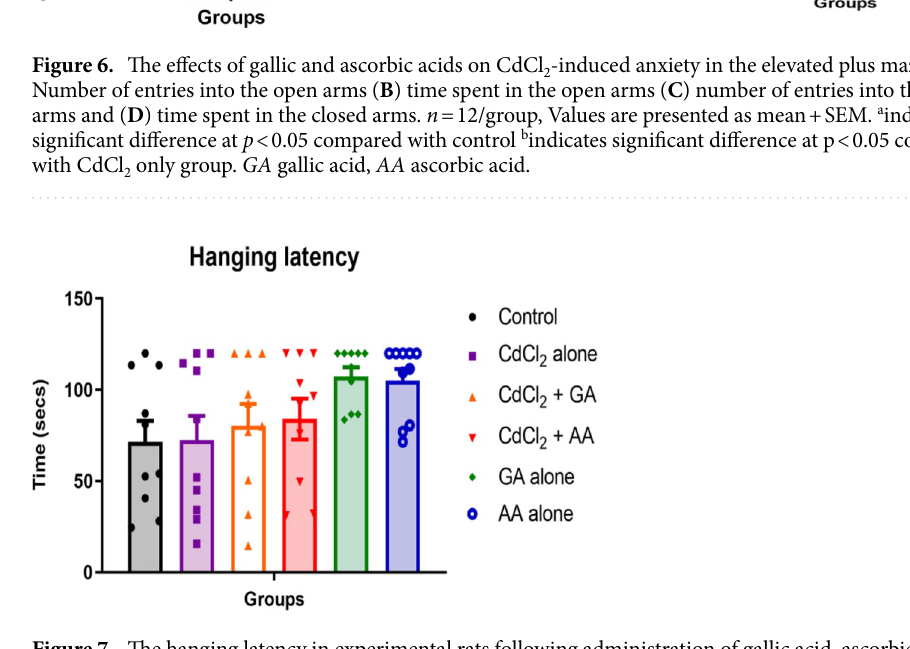
Figure 7. The hanging latency in experimental rats following administration of gallic acid, ascorbic acid and CdCl 2 Values are presented as mean + SEM ( n =